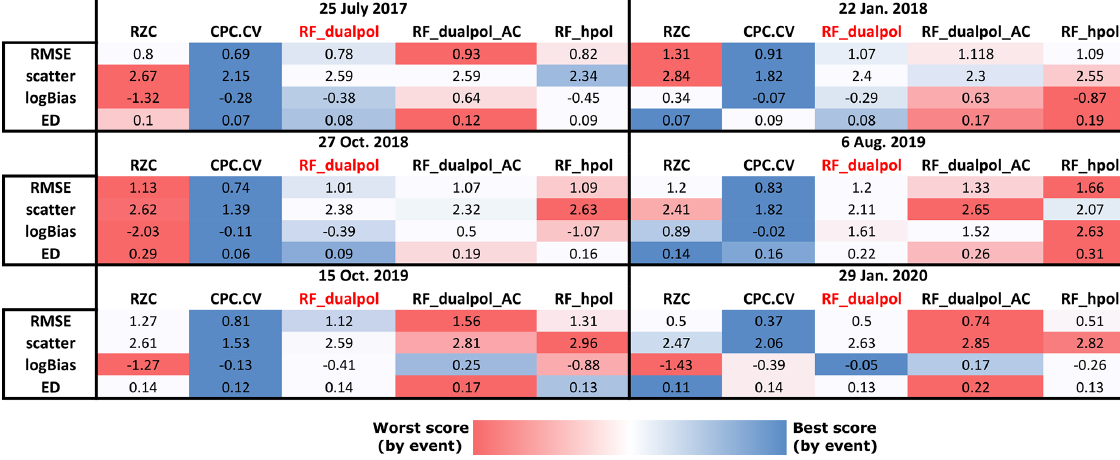
Figure 15. Evaluation scores at hourly resolution for the RZC, CPC.CV, RF_dualpol (with Gaussian smoothing), RF_dualpol_AC (advection- corrected) and RF_hpol (with Gaussian smoothing) methods for the six events using the rain gauge measurements from all Swiss stations as reference. Green colors correspond to good relative performance and red colors to poor relative